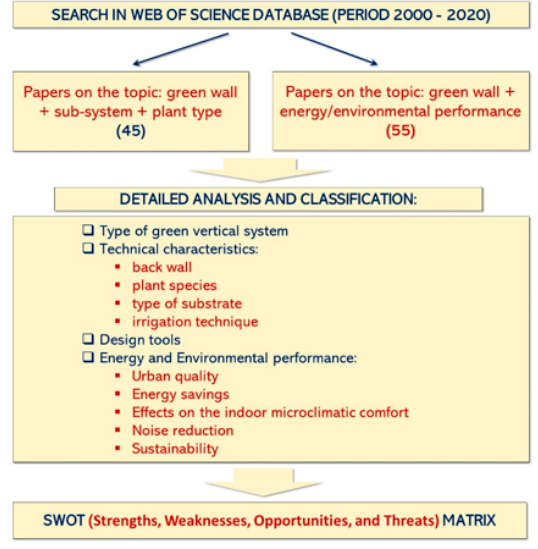
Figure 3. PRISMA flow diagram: the review method.